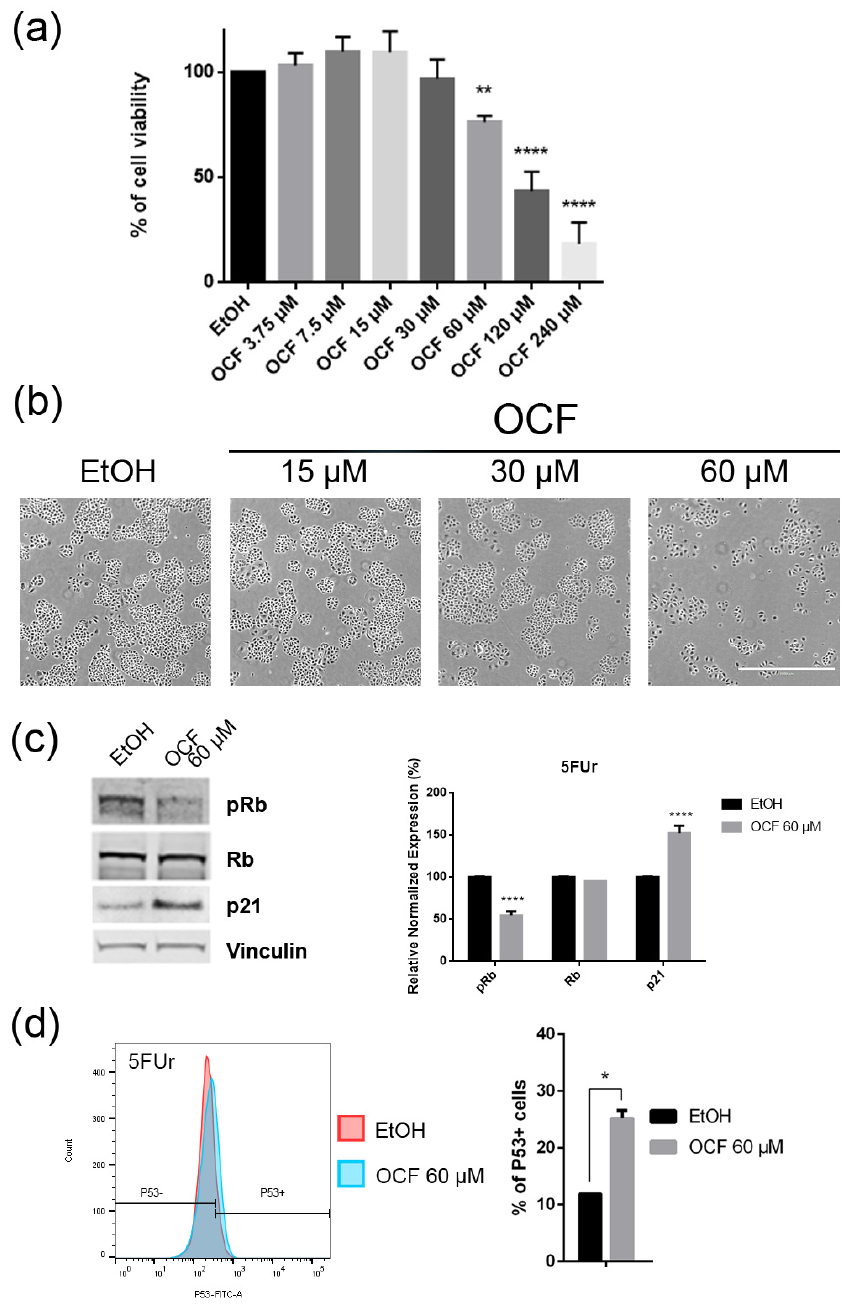
Figure 4. Effects of different doses of OCF on the 5FUr cells. 5FUr cells, treated for 72 h with vehicle or with different doses of the OCF, were analyzed through a MTT assay ( a ); pictures were obtained with an inverted microscope at 4x magnification ( b ); representative western blot analysis of p-Rb, Rb, p21 and vinculin levels in 5FUr cells were treated with vehicle or 60 µM dose of the OCF for 24 h and the corresponding densitometry ( c ). Flow cytometry plots for the p53 staining and corresponding histograms ( d ). Data are presented as mean ± SD of three independent experiments. Results of the representative experiments are shown. * p < 0.05, ** p < 0.01, **** p < 0.0001. ( a ) One-way ANOVA Dunnett’s multiple comparisons test; ( c , d ) Two-way ANOVA Sidak’s multiple comparisons